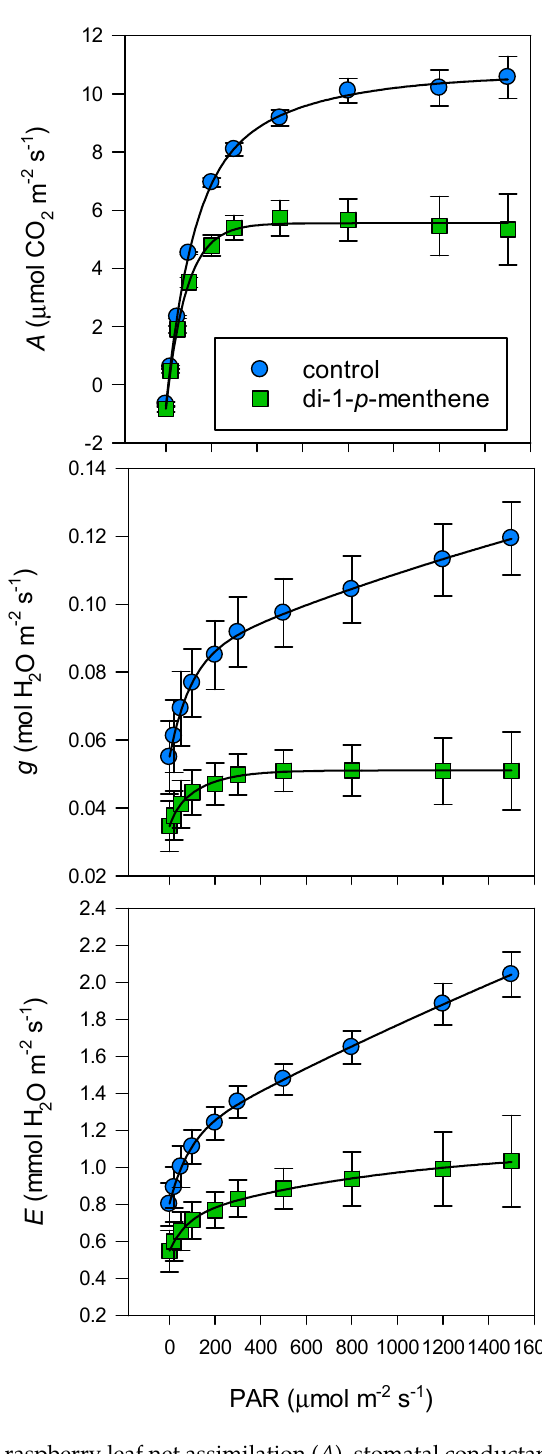
Figure 2. ‘’Tulameen” raspberry leaf net assimilation ( A ), stomatal conductance ( g ) and transpiration ( E ) in response to a range of photosynthetically active radiation (PAR) following treatment with 1% di-1- p -menthene to both leaf surfaces. Control leaves were treated with dH 2 O only. Measurements were carried out at ambient CO 2 and 25 ◦ C. Leaf gas exchange was monitored 48 h after application. Data are expressed as means ± s.e.m., n = 5, p < 0.001 for A , g and E